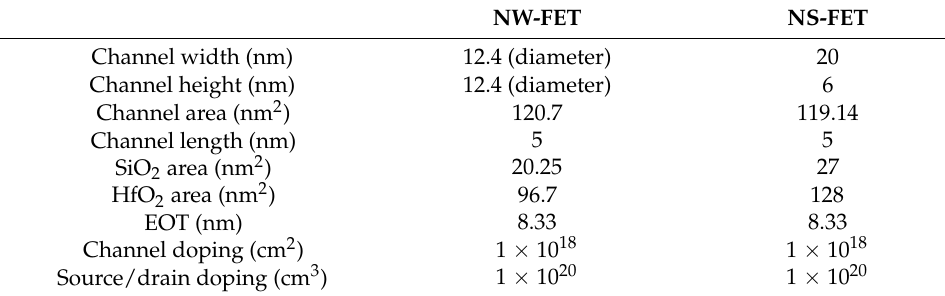
Table 1. The specifications of internal